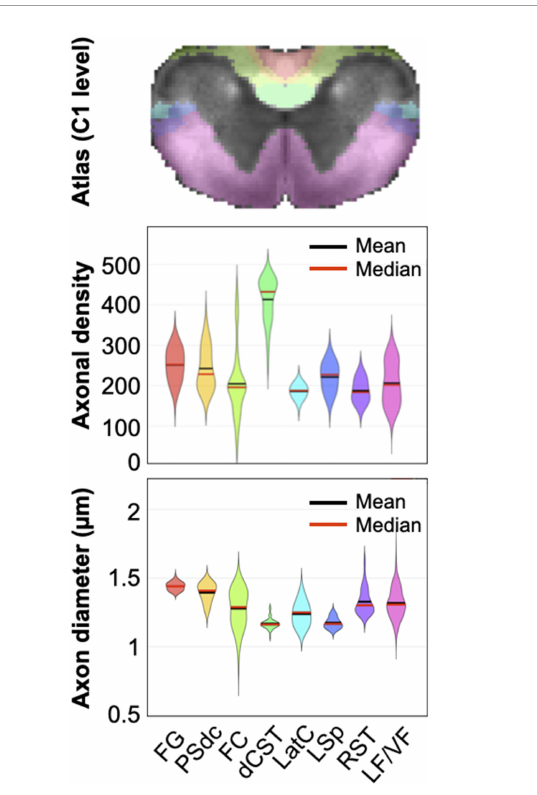
FIGURE7 Results of clustering with a varying number of clusters (from 8 to 31) at C7 level. Clustering results are shown on the left half of each spinal cord, while the Watson atlas is shown on the right half.